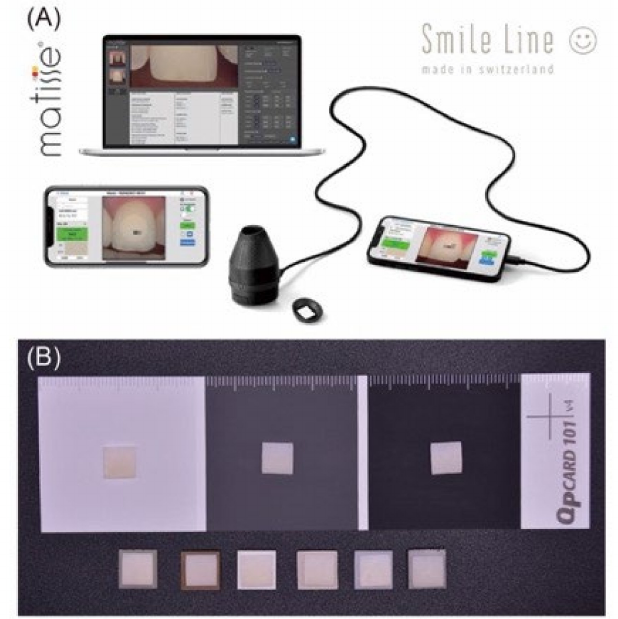
Figure 2. ( A ) Schematic of optical measurement and ( B ) the appearance of the testing sample placed on different